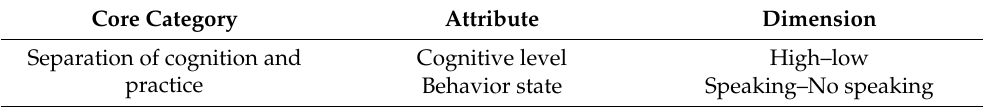
Table 4. Core category and refinement analysis.